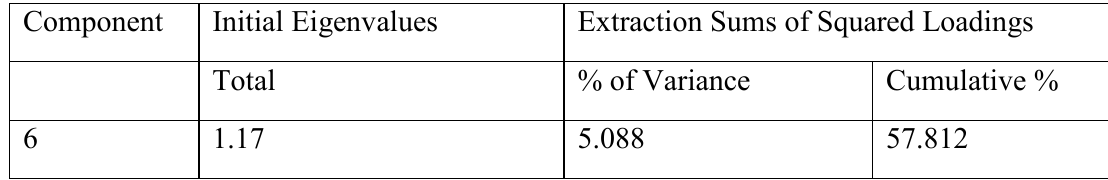
Table 1.33: Variance explained for Adaptive Resilience PC6